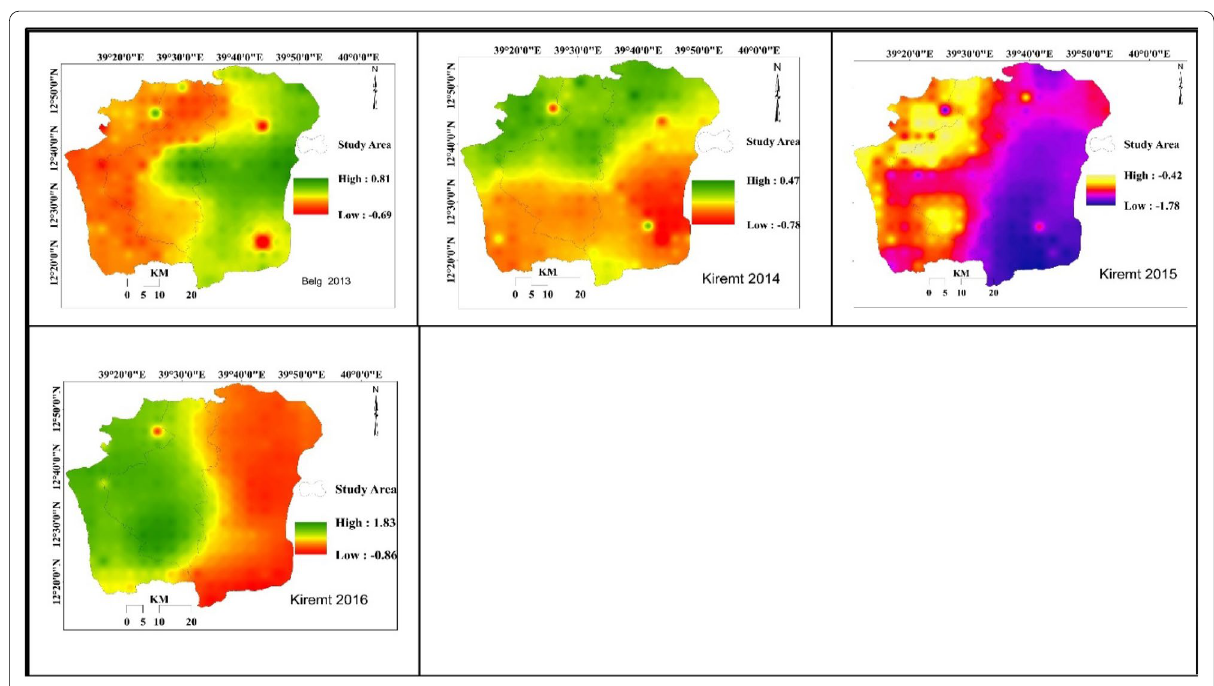
Fig. 5 temporal charts and spatial SPEI maps in Fig. 7 were